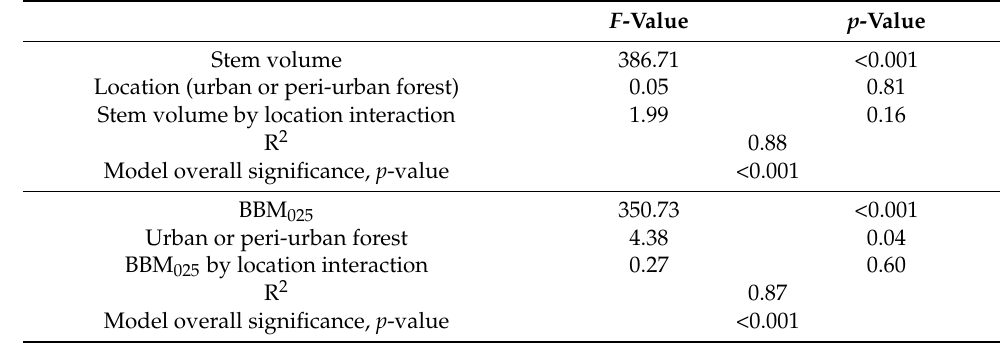
Figure 2. Basal bending moment of silver birch stems at the secondary failure (BBM SF ) against stem volume ( A ) and the basal bending moment at the stem base inclination of 0.25 ◦ (BBM 025 ) ( B ). The shaded area indicates 95% confidence interval. Table 4. Regression between basal bending moment of birch at secondary failure (BBM SF ), stem volume and basal bending moment at the stem base inclination of 0.25 ◦ (BBM 025 ) by the location in urban or forest sites.